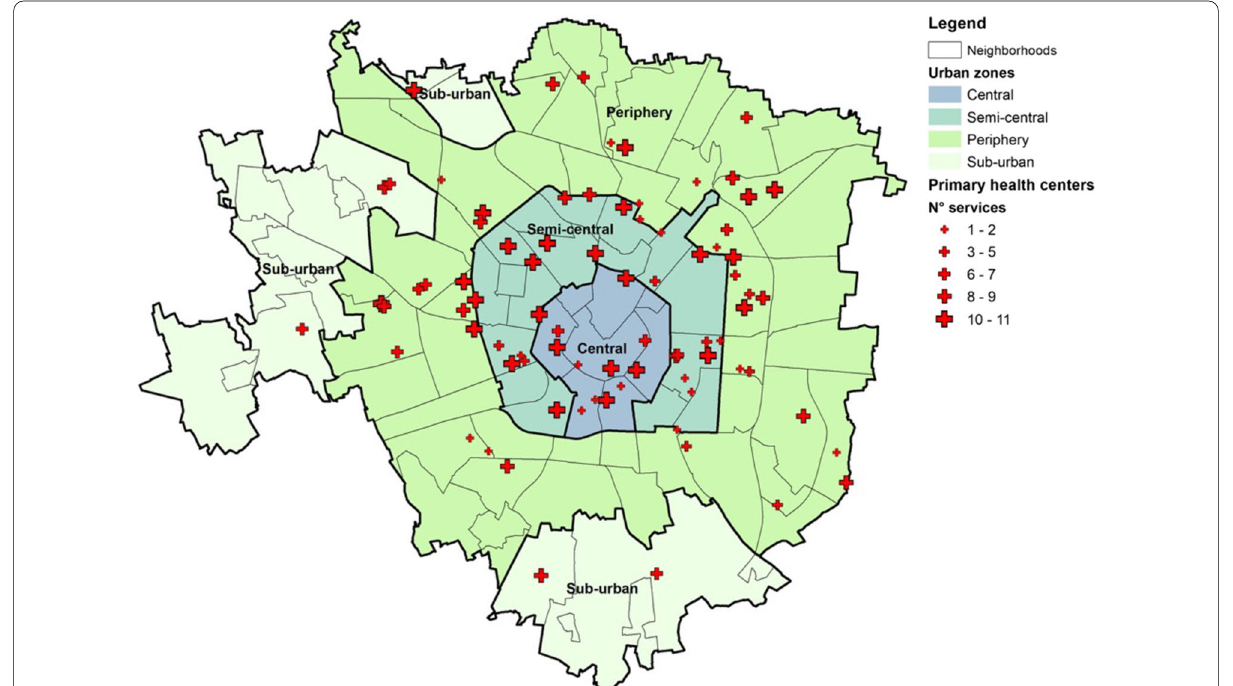
Fig. 3 The administrative structure and primary health buildings in the city of